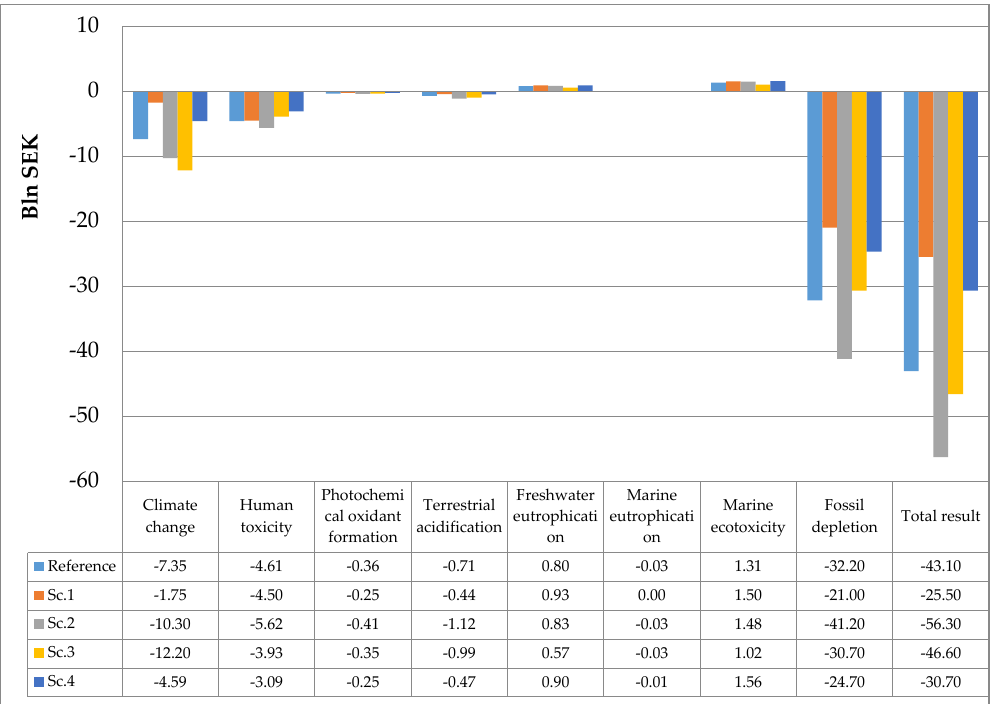
Figure 3. Relative cumulative energy demand of the waste treatment system (including avoided burdens) for the four base scenarios compared to the reference scenario set to 100%.